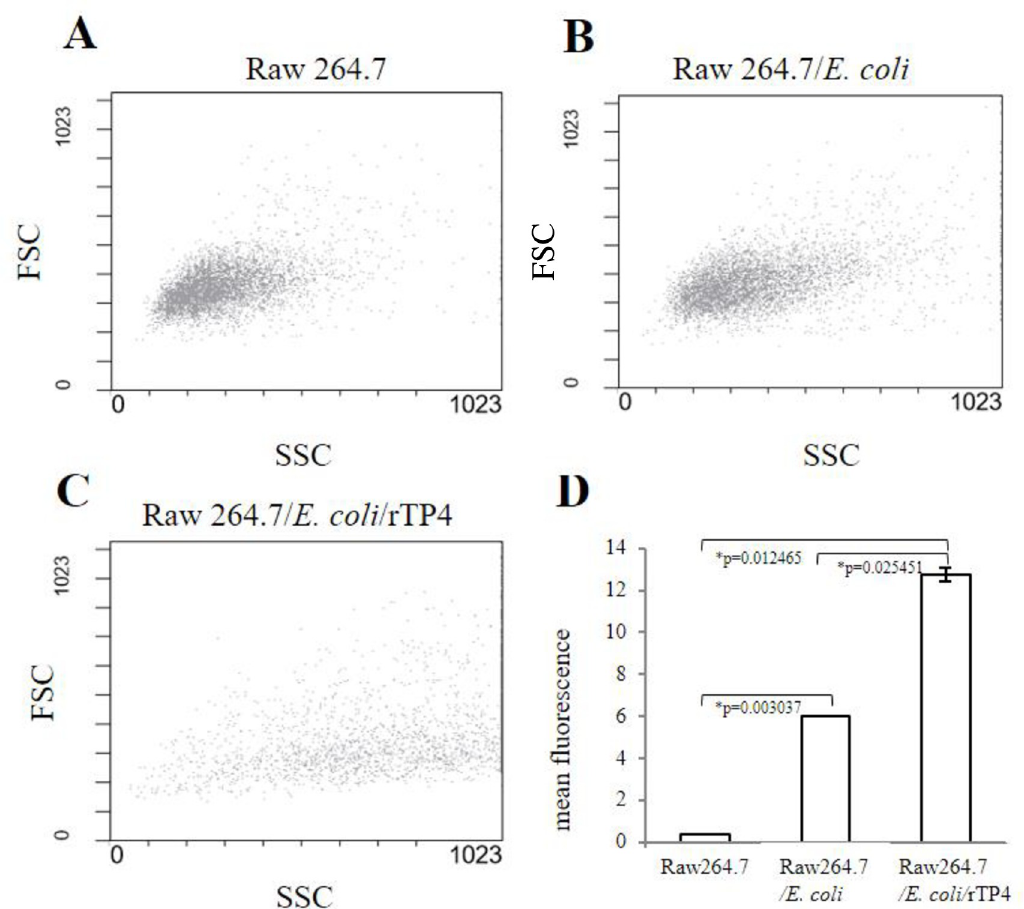
Fig 3. Flow cytometry phagocytosis assay. Flow cytometry analysis using cell size forward-scattered light (FSC) and side- scattered light (SSC) parameters was performed. ( A ) RAW264.7 cells alone, ( B ) RAW264.7 cells coincubated with E . coli , and ( C ) RAW264.7 cells treated with rTP4 and coincubated with E . coli . ( D ) The mean fluorescence intensity (MFI) of RAW264.7 cells was analyzed, and the asterisks indicate significant differences. than that in the basal diet group animals and similar to that in the Spiraline-A group animals (Table 2). The protein efficiency ratios of G . g . domesticus in the 0.75% and 1.5% rTP4-fed ani- mals were higher than those in the animals in other groups (Fig 4). The survival rate of animals fed 1.5% rTP4 was lower than that of the animals in other groups, which was caused by one chicken dying from disease and two chickens dying after pecking an infected carcass. Morpho- logical measurements of the heart, liver, spleen, lung, kidney and intestine are given in Fig 5. Histological examination of tissues showed white blood cell aggregates in the coronary vein of the heart in the antibiotic group (Fig 5A, black arrow). This phenomenon was not found in the coronary veins of the 3% rTP4 group or basal diet group. Microscopic examination of tissue sec- tions, including those of the heart, liver, spleen, lung, kidney and intestine, in the three groups was normal, and no other symptoms were observed. Microbial profiles of the duodenum in chickens with different treatments were determined using high-throughput sequencing of the bacterial 16S rRNA gene. The results showed that the duodenum was predominantly populated by Peptostreptococcaceae and Erysipelotrichaceae . Reduced total viable counts of Ruminococca- ceae and Lachnospiraceae were also observed after feeding with rTP4 (Fig 6).